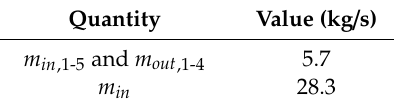
Table 2. Value of the fixed mass flow rate BCs. (Reproduced from [14], Politecnico di Torino: